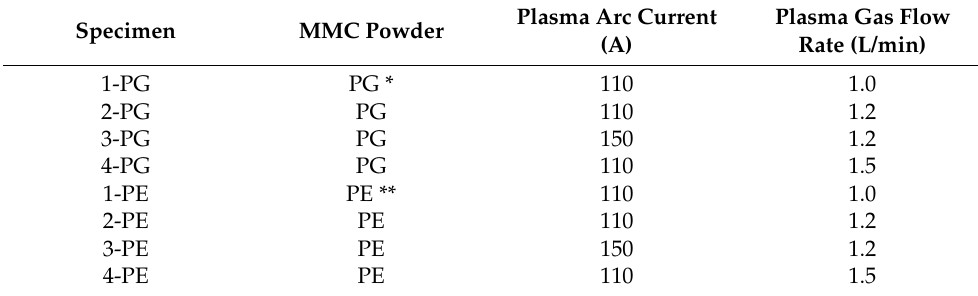
Figure 2. EuTronic© Gap 3511 DC synergic system used for PPTAW process. Table 2. PPTAW process parameter variation for specimen preparation, Travel Speed, V = 1.3 mm/s.